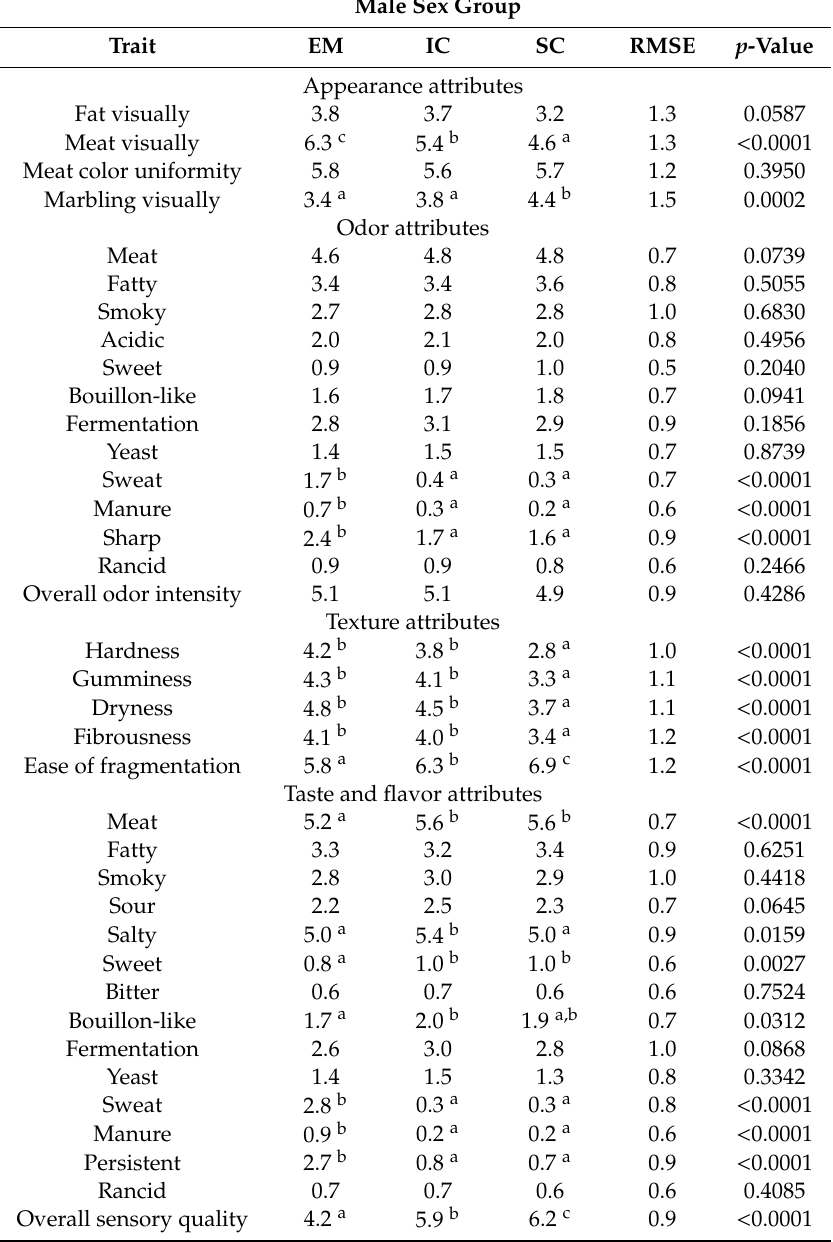
Table 4. E ff ect of sex group on sensory traits of dry-cured